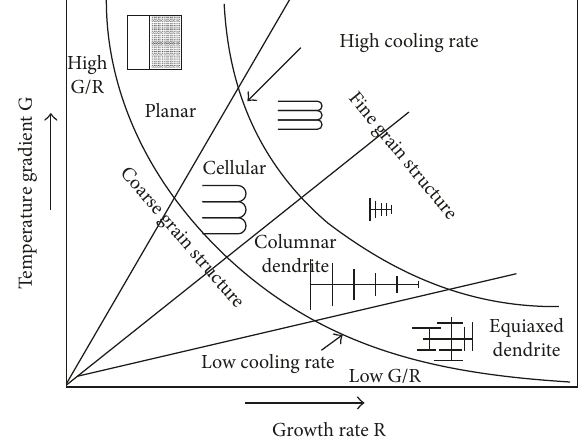
Figure 2: Influence of temperature gradient (G) and growth rate (R) on the mode of solidification and grain structure